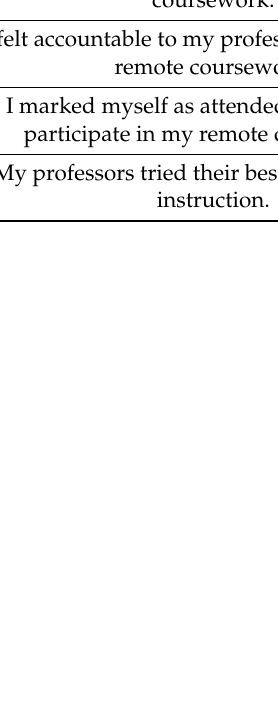
Table 6. Student Needs, Behavior, and Perception of